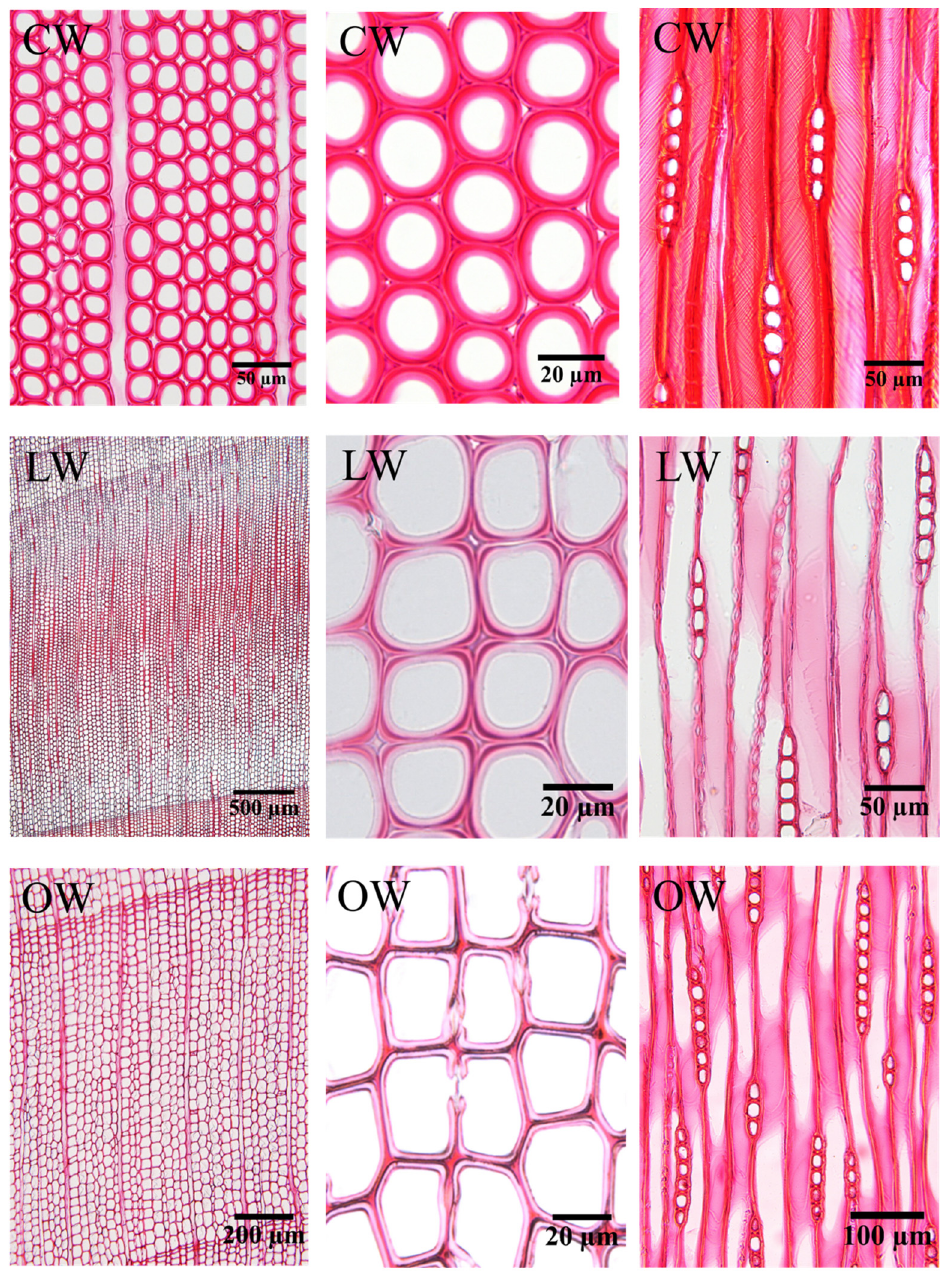
Figure 4. Anatomical structure of CW, LW, and OW of T . Zhongshanshan. From top to bottom: CW, LW, and OW.